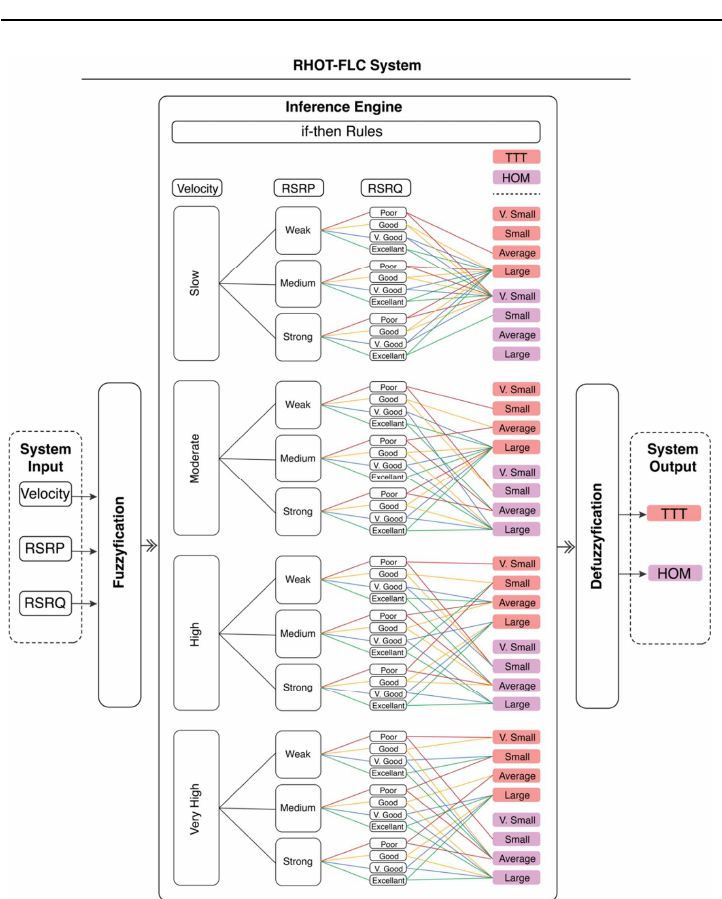
Figure 2. RHOT-FLC proposed